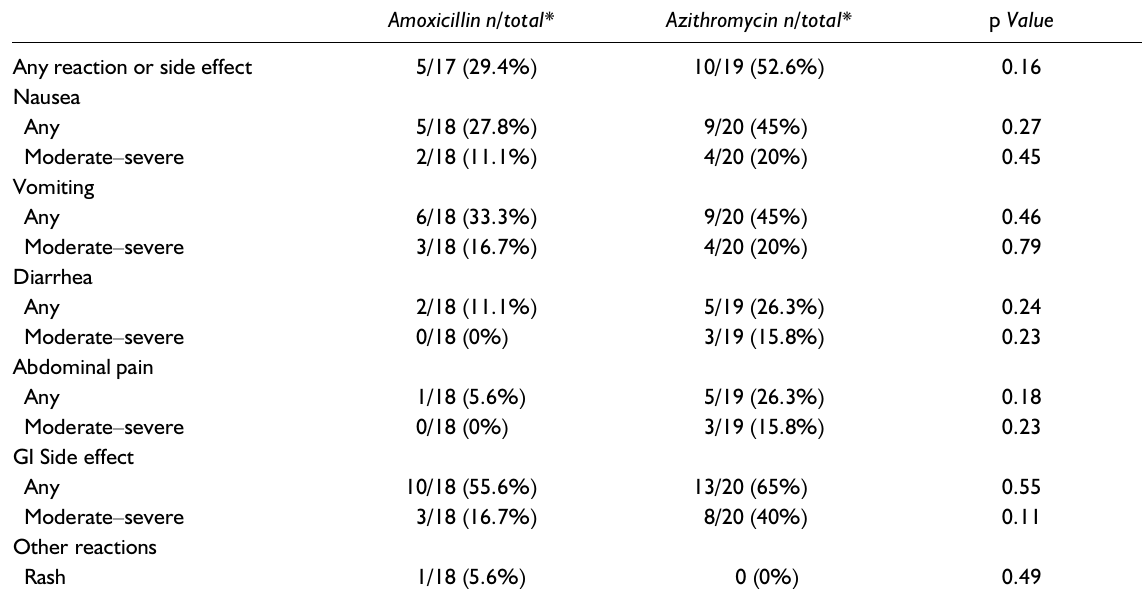
Table 2 Reported side effects by treatment